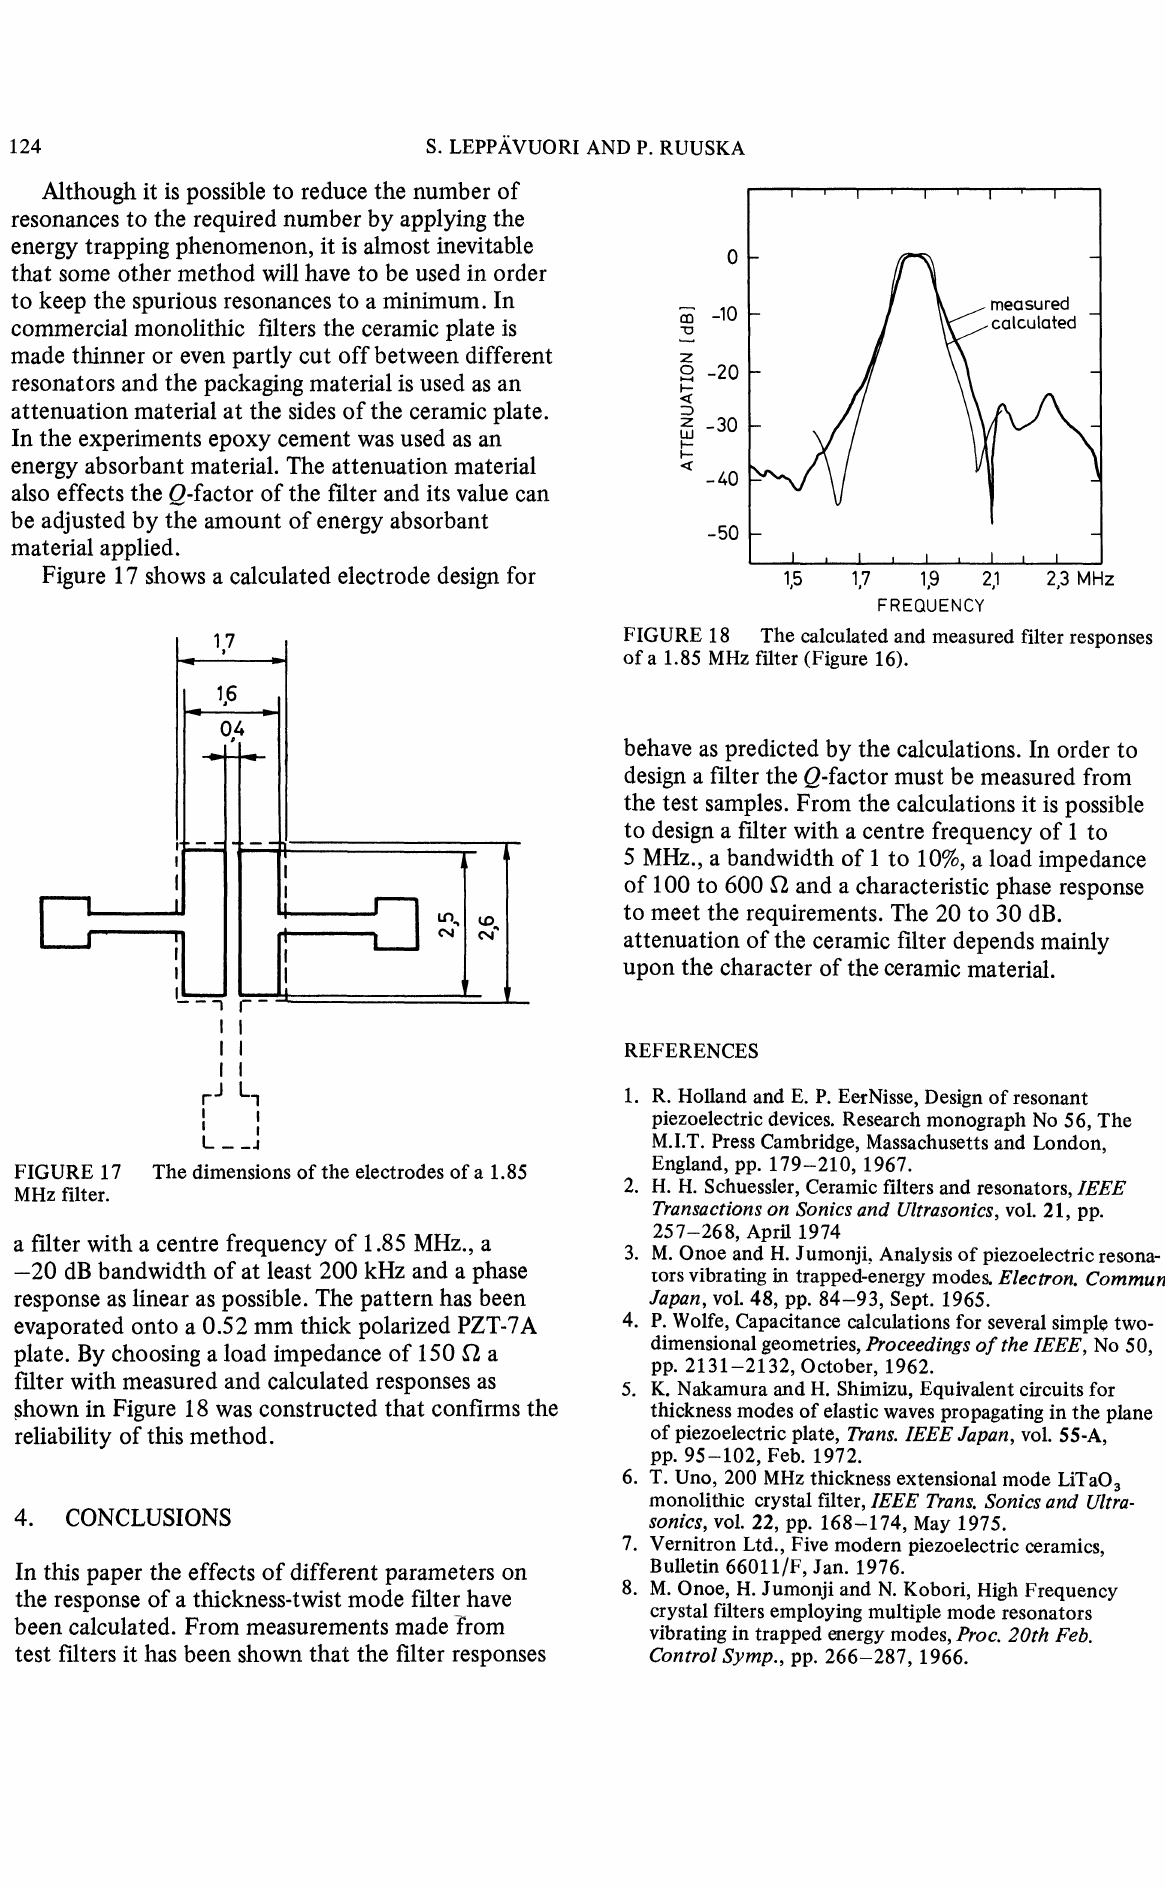
r-J L- FIGURE 17 The dimensions of the electrodes of a 1.85 MHz filter.